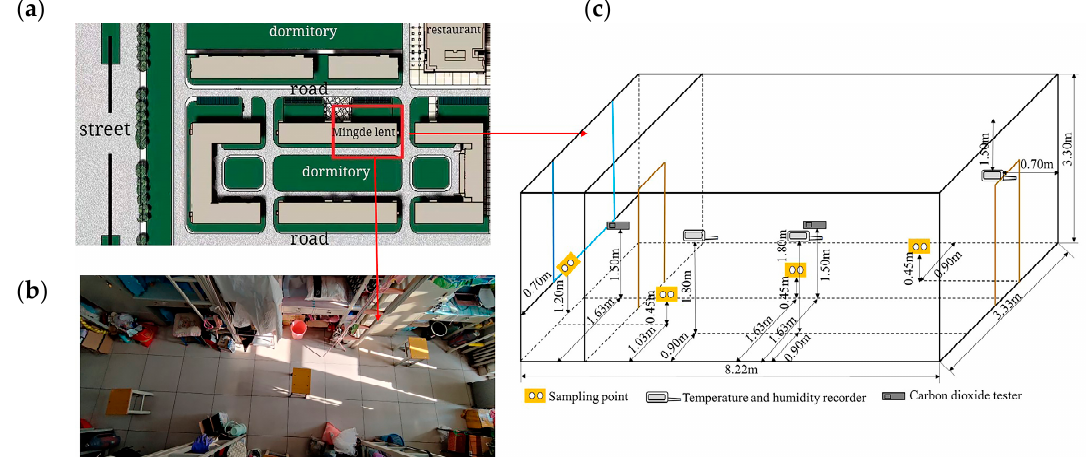
Figure 1. Layout of the tested dormitory and the indoor sampling positions: ( a ) building location; ( b ) indoor view of room; ( c ) sampling points.